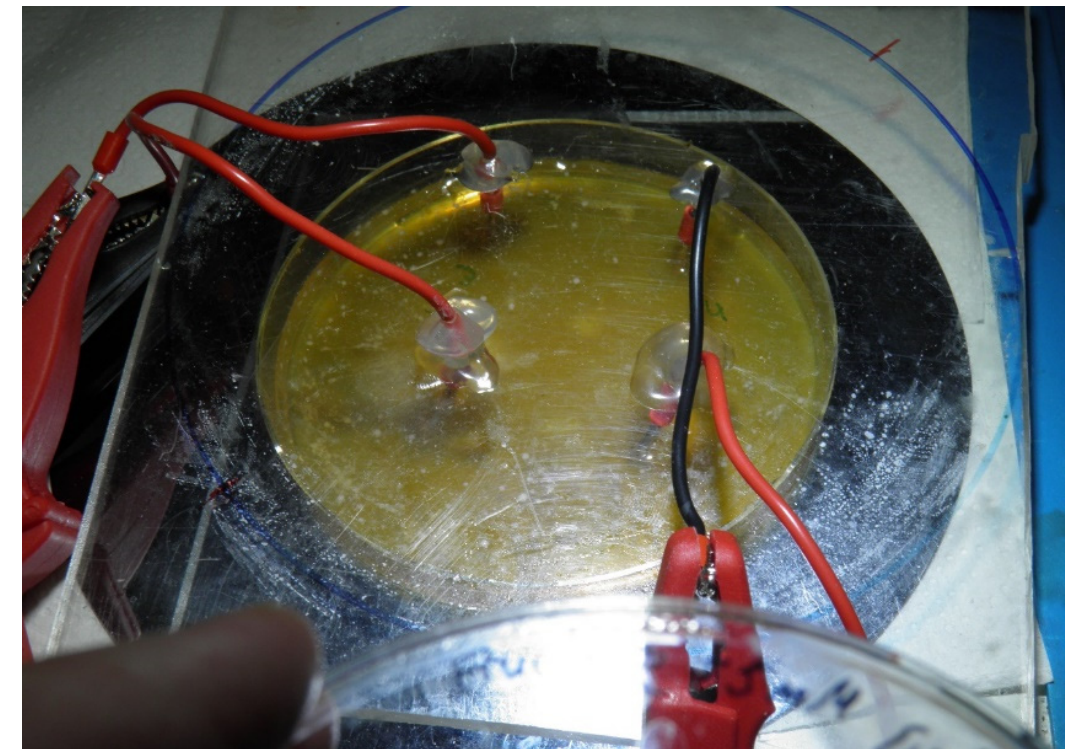
Figure 6. Two pairs of electrodes were placed in gelatin in a Petri dish. Gelatin contained 0.9 mM/kg Eu and 5 mM/kg organic substrate. Electrode pairs were used to determine and compare voltages at different sites of lines in Petri dish. The device was isolated from air by a plexiglass™ cover plate through which electrode wires were passed, with glue closing the drilled holes. Upon illumination, slow chemical waves formed, indicated by reversal of sign of voltage at different times at the two pairs of electrodes, e.g., when consuming mannose, sarcosine, or aniline. Period length was about 24 h, and propagation took place at about 1 mm/h. Distance among electrode pairs was 2.8 cm. The maximum current densities were much higher in this Ta system than when using Cu,